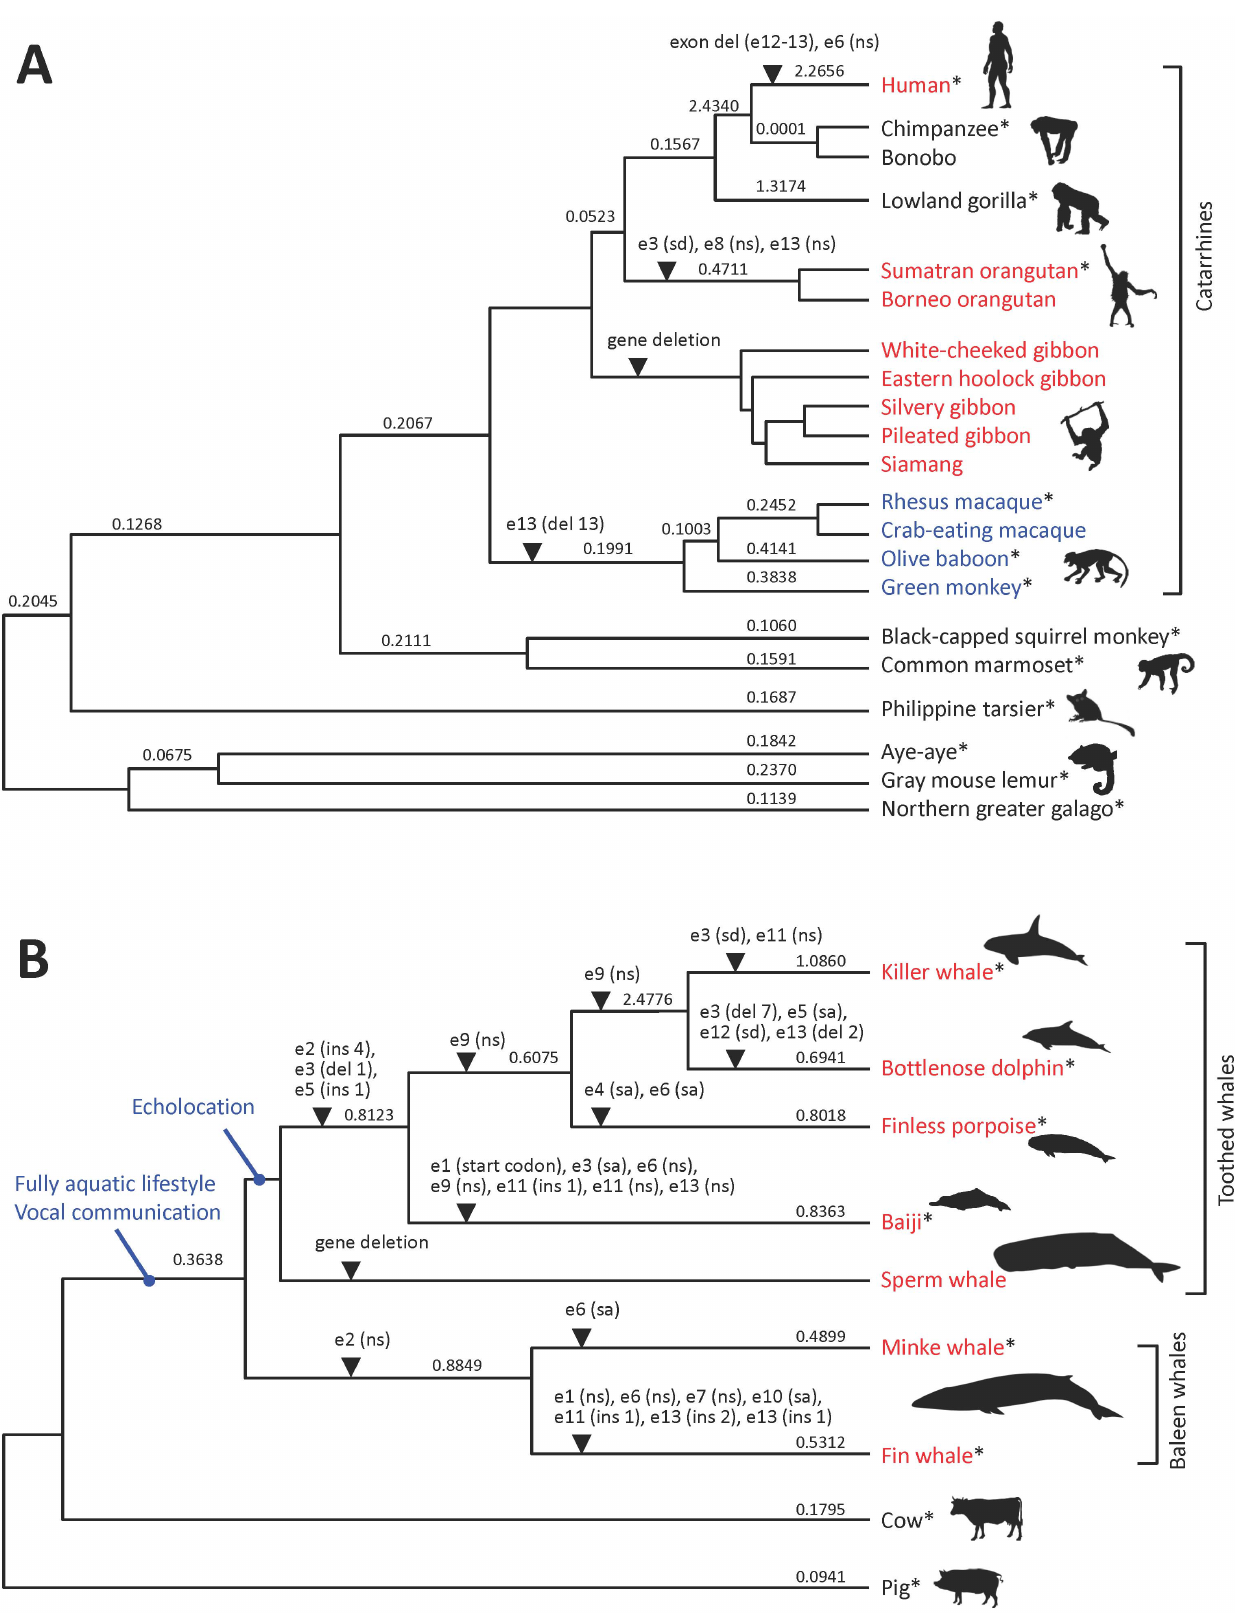
Figure 6. Molecular evolution of the MOXD2 gene in catarrhines and whales. Molecular evolutionary histories of the MOXD2 gene in catarrhines (A) and whales (B) are presented. Gene-disrupting mutations are indicated with arrowheads. dN/dS ratios ( v ) estimated by the ‘‘free-ratio’’ model are presented on each branch. Asterisks indicate species of which coding sequences were used for the dN/dS analysis. e # , exon number; ins, PLOS ONE |